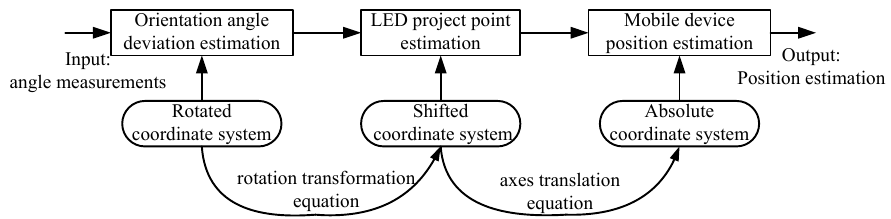
Figure 4. Block diagram of the proposed VLC based positioning